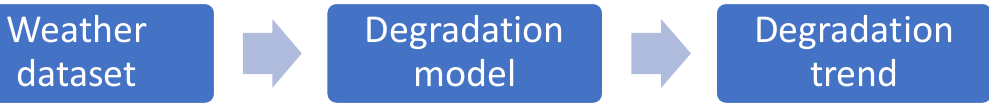
Figure 1. PV degradation forecasting for an assigned PV module technology.